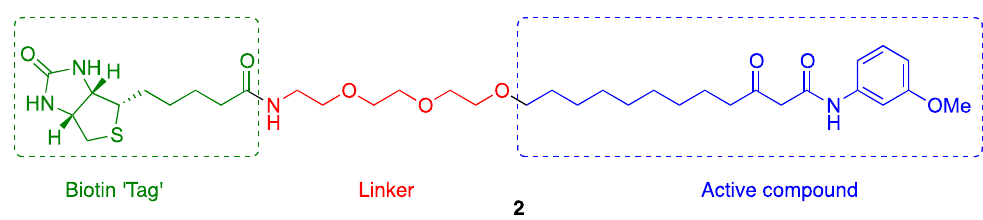
Figure 2. The target biotinylated affinity